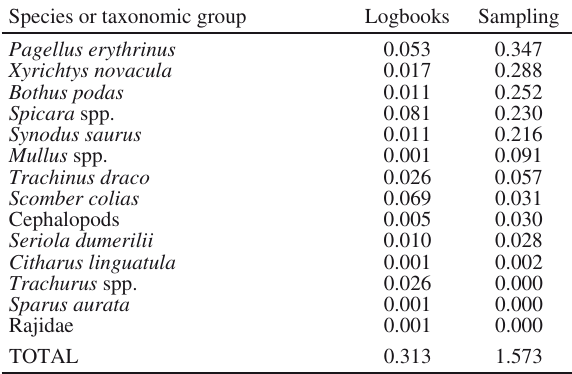
Table 1. – By-catch of sand eel fishery, expressed as percentage in weight, according to two sources: logbooks (accounting for 843 tons of sand eel) and sampling (accounting for 9.6 t of sand